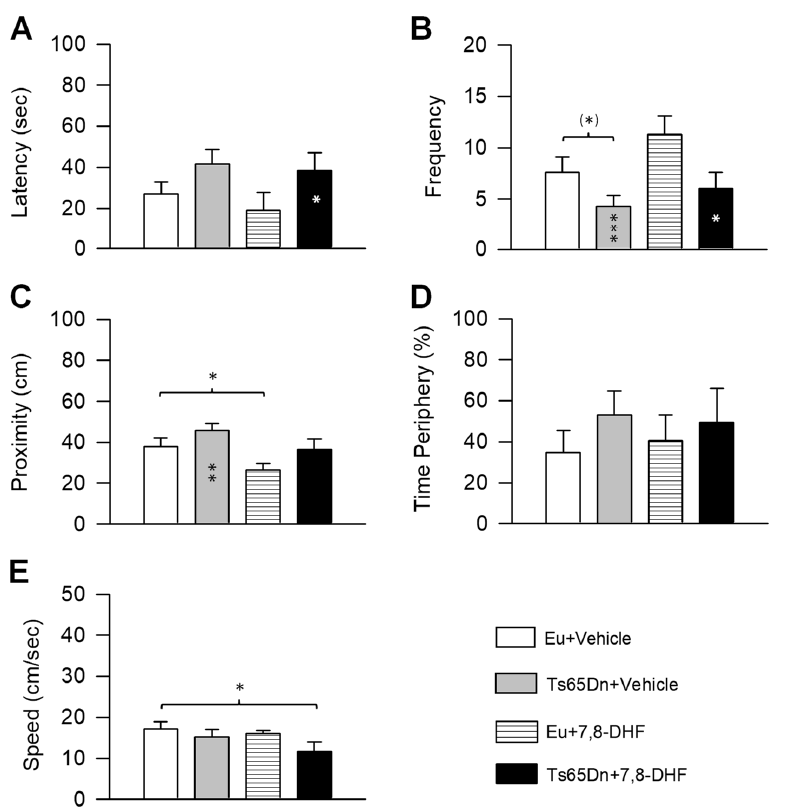
Figure 5. Effect of treatment with 7,8-DHF on spatial memory in adult Ts65Dn and euploid mice. Memory was assessed in the probe test as latency to reach the former platform zone ( A ), frequency of crossings over the former platform quadrant ( B ), proximity to the former platform zone ( C ), percentage of time spent at the periphery ( D ) (same mice as in Figure 4). E: Swimming speed during the probe test. Values are mean ± SE. (*) p < 0.06; * p ≤ 0.05; ** p ≤ 0.01; *** p ≤ 0.001; (Fisher LSD test after ANOVA). Black asterisks in the gray bar indicate a difference between untreated Ts65Dn mice and treated euploid mice; white asterisks in the black bar indicate a difference between treated Ts65Dn mice and treated euploid mice. Abbreviations: 7,8-DHF, 7,8-dihydroxyflavone; cm, centimeters; Eu, euploid; sec, seconds.